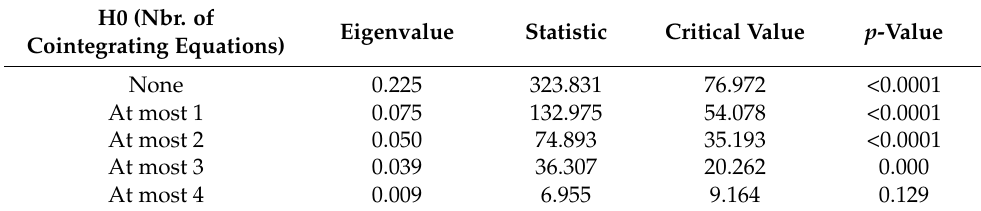
Table 4. Trace test, Johansen-Juselius procedure, authors source.